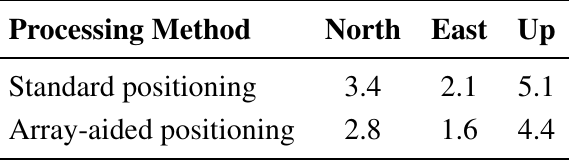
Table 4. Empirical angular standard deviation (deg) for the attitude determination using the epoch-by-epoch processing of the static data (0.6-m baseline).